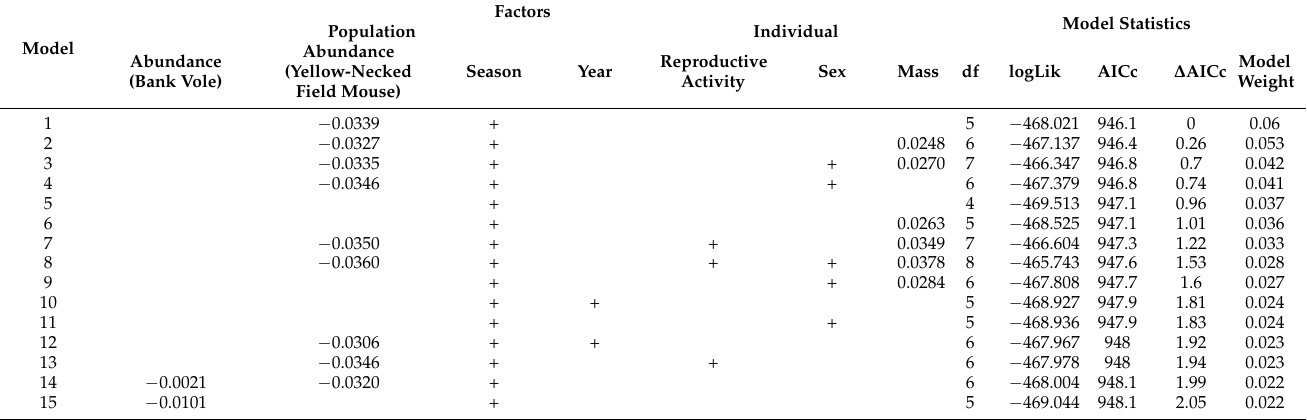
Table 4. Binomial generalized linear models explaining the probability of BvHV infections in bank voles. Presence of a factor within a candidate model is indicated either by a + for categorical factors or the estimate for continuous factors. If a factor is not included in a candidate model, the cell remains empty. Models with ∆ AIC > 2 were excluded from subsequent model averaging. AIC of the null model was 958.7 and was therefore not included in the Table below. df = degrees of freedom; logLik = log-likelihood value.